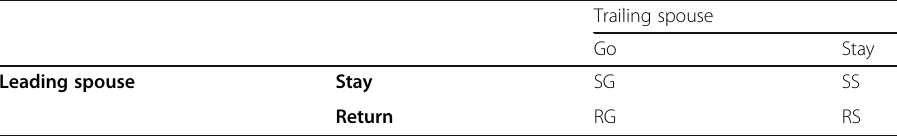
Table 1 The reunification stage of the family migration-and-reunification game as an adaptation of Lundberg and Pollak ’ s (2003) two-earner couple location problem,